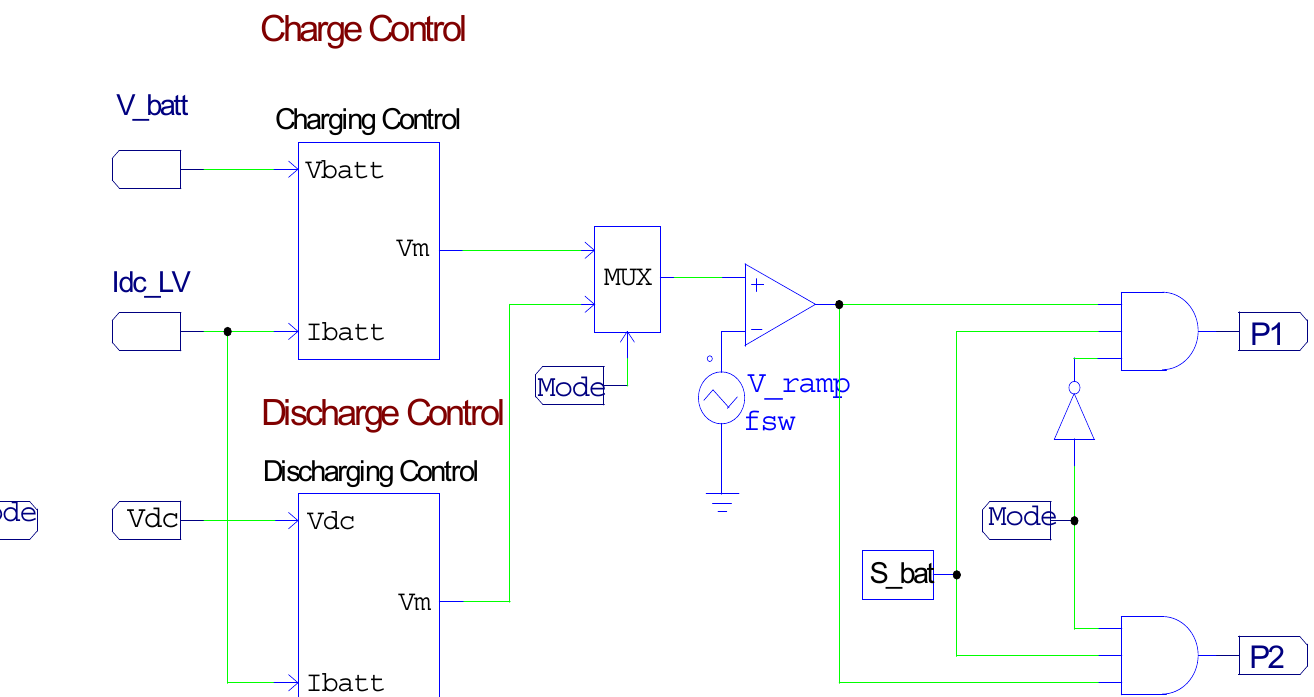
Figure A2. Modelling for battery charge/discharge control system.